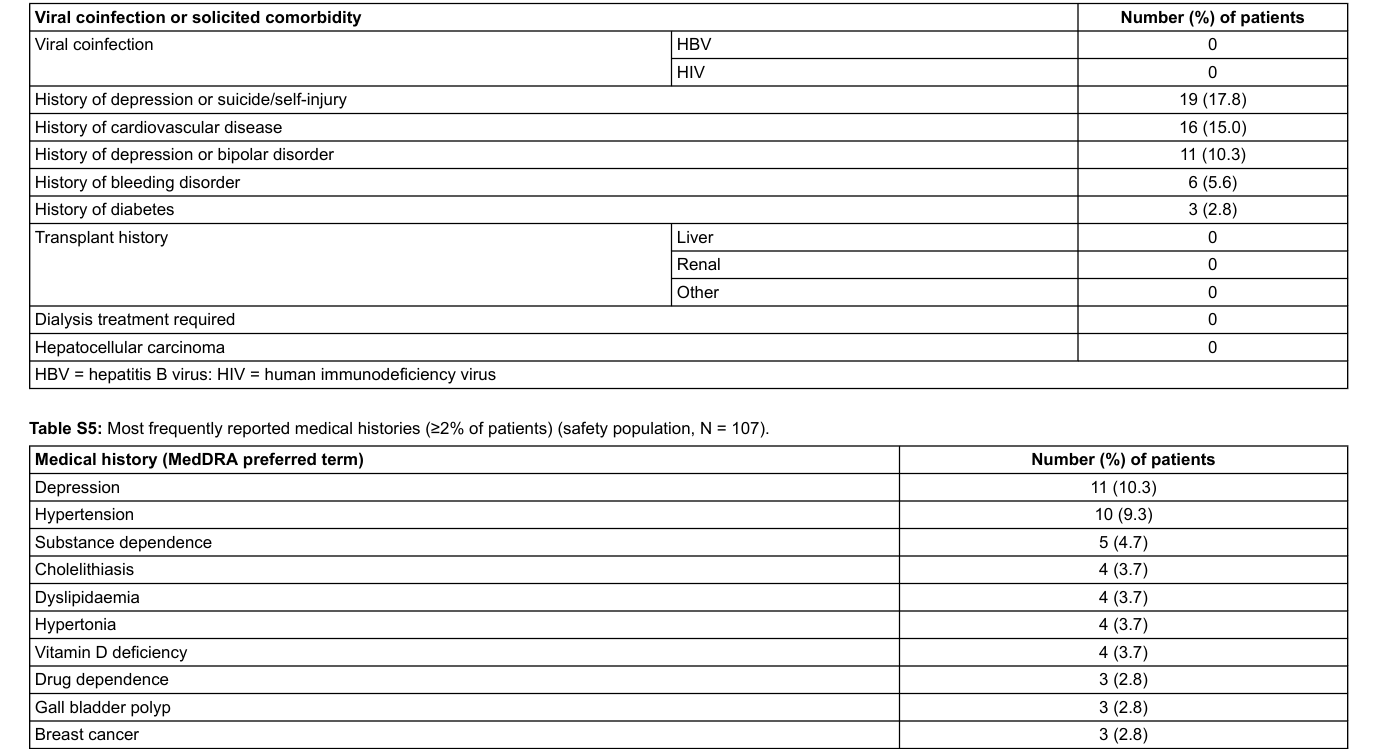
Table S4: Viral coinfections and solicited comorbidities (safety population, N = 107).